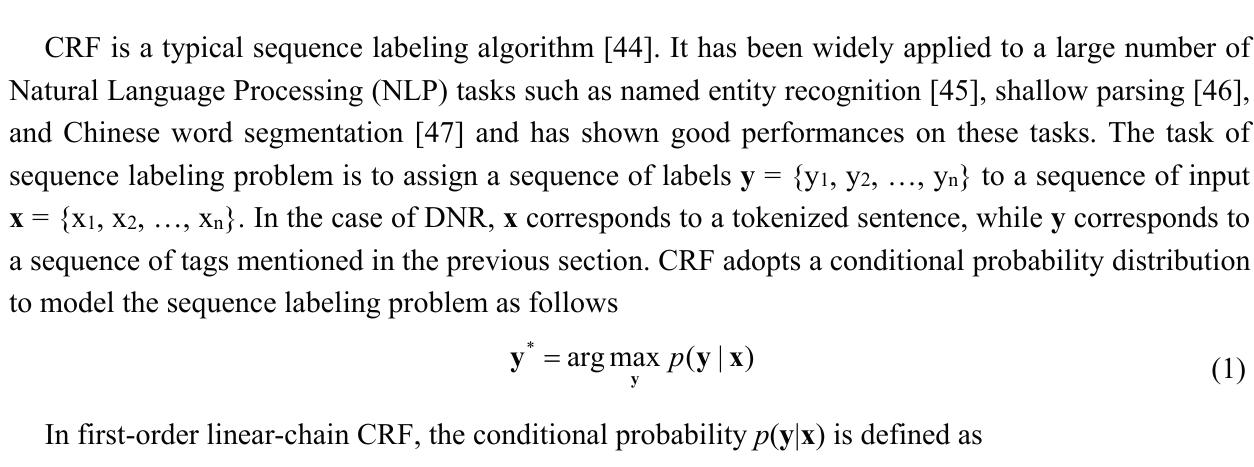
Figure 2. An example of a sentence labeled by BILOU